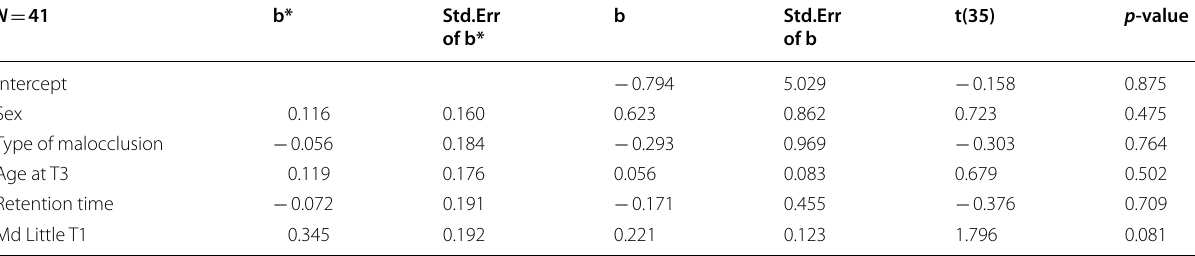
Regression summary for dependent variable: Md Little